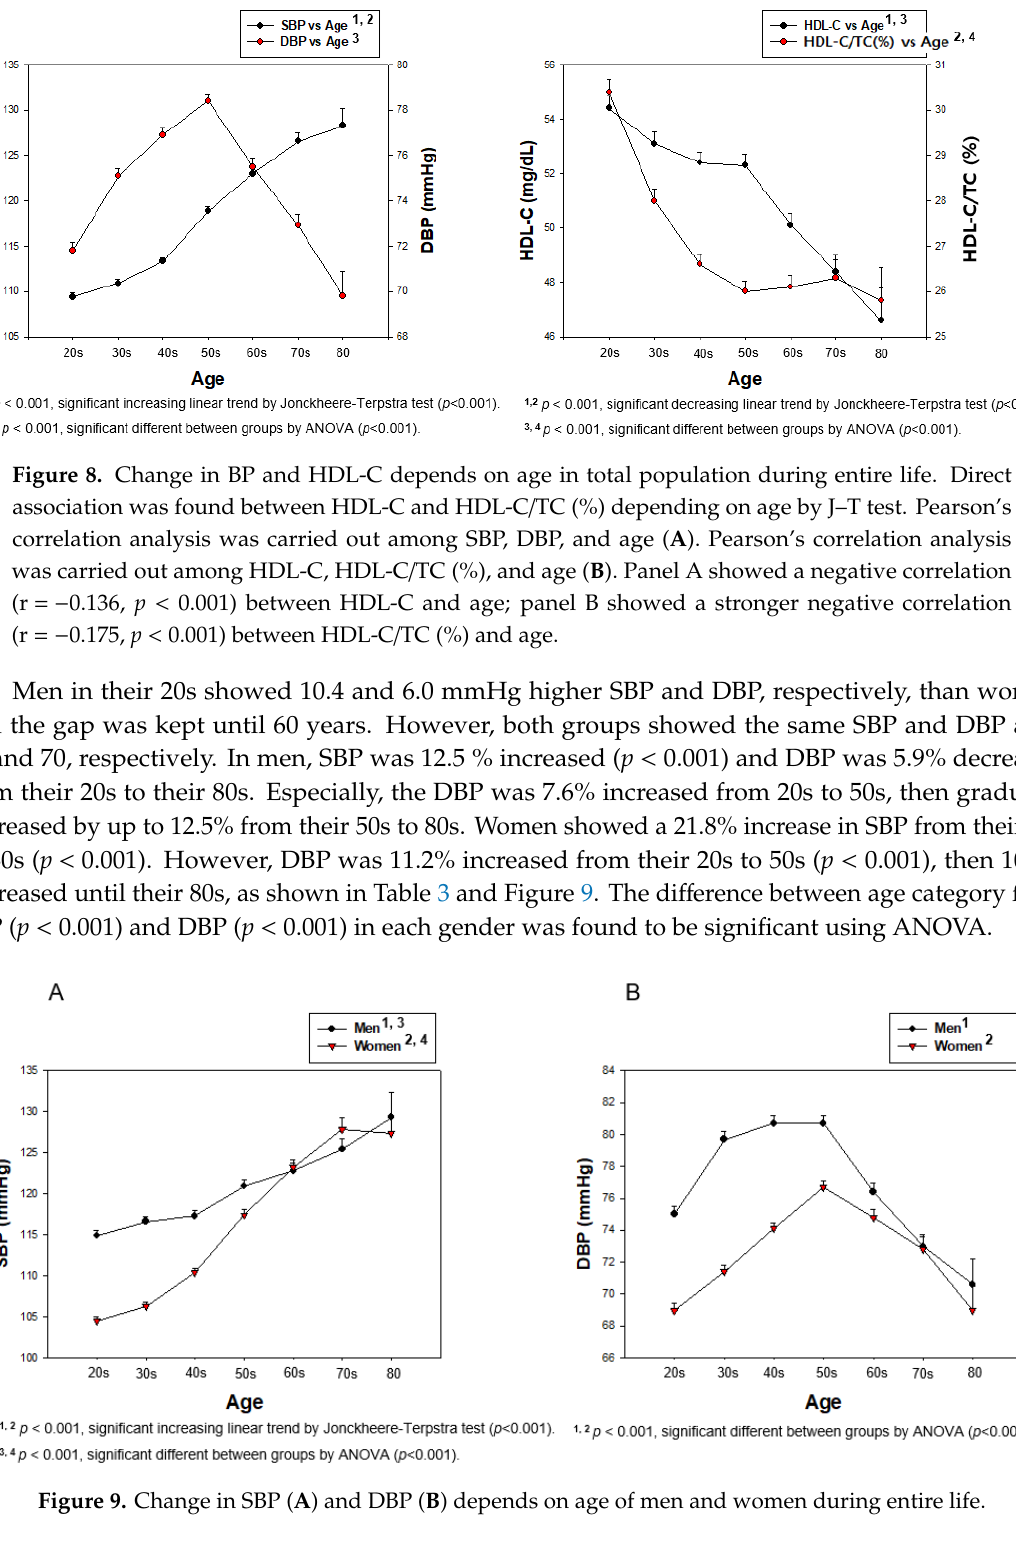
Figure 10. Change in HDL-C ( A ) and HDL-C/TC (%) ( B ) depends on age in men and women during entire life. A direct association was found of SBP depending on age in panel A by J –T test. Pearson’s correlation analysis was carried out between age and HDL-C (A) and HDL-C/TC (%) (B). Panel A showed r = − 0.090 ( p = 0.00005) in men and r = − 0.184 ( p < 0.001) in women between HDL-C and age. Panel B showed r = − 0.037 ( p = 0.100) in men and r = − 0.297 ( p < 0.001) in women between HDL-C/TC (%) and age.